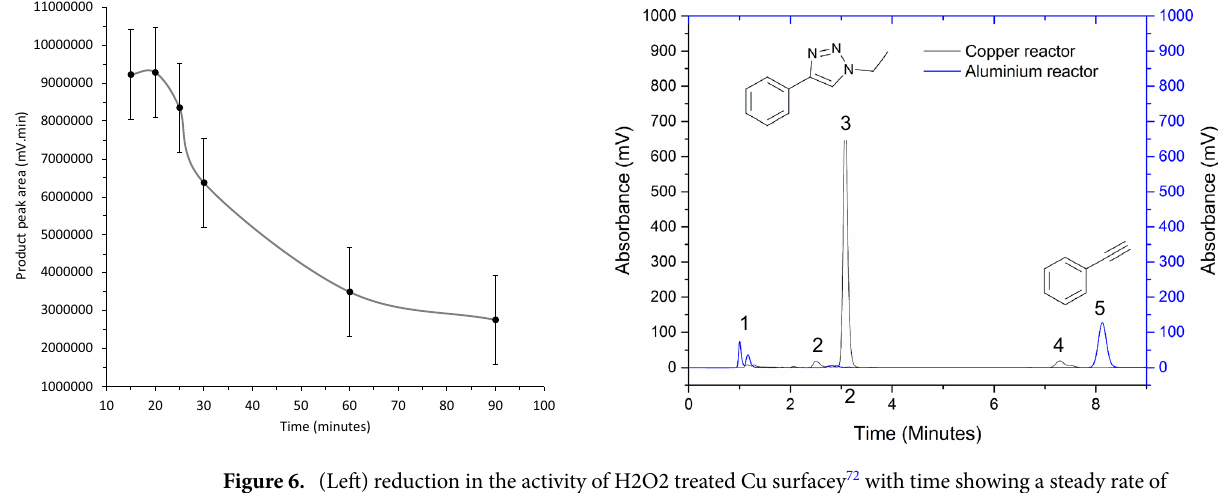
Figure 6. (Left) reduction in the activity of H2O2 treated Cu surfacey 72 with time showing a steady rate of reduction until approximately 90 min (right) Comparison of Cu and Al reactors demonstrating the absence of starting material (5) in the Cu reactor and the absence of product (3) in the Al reactor.